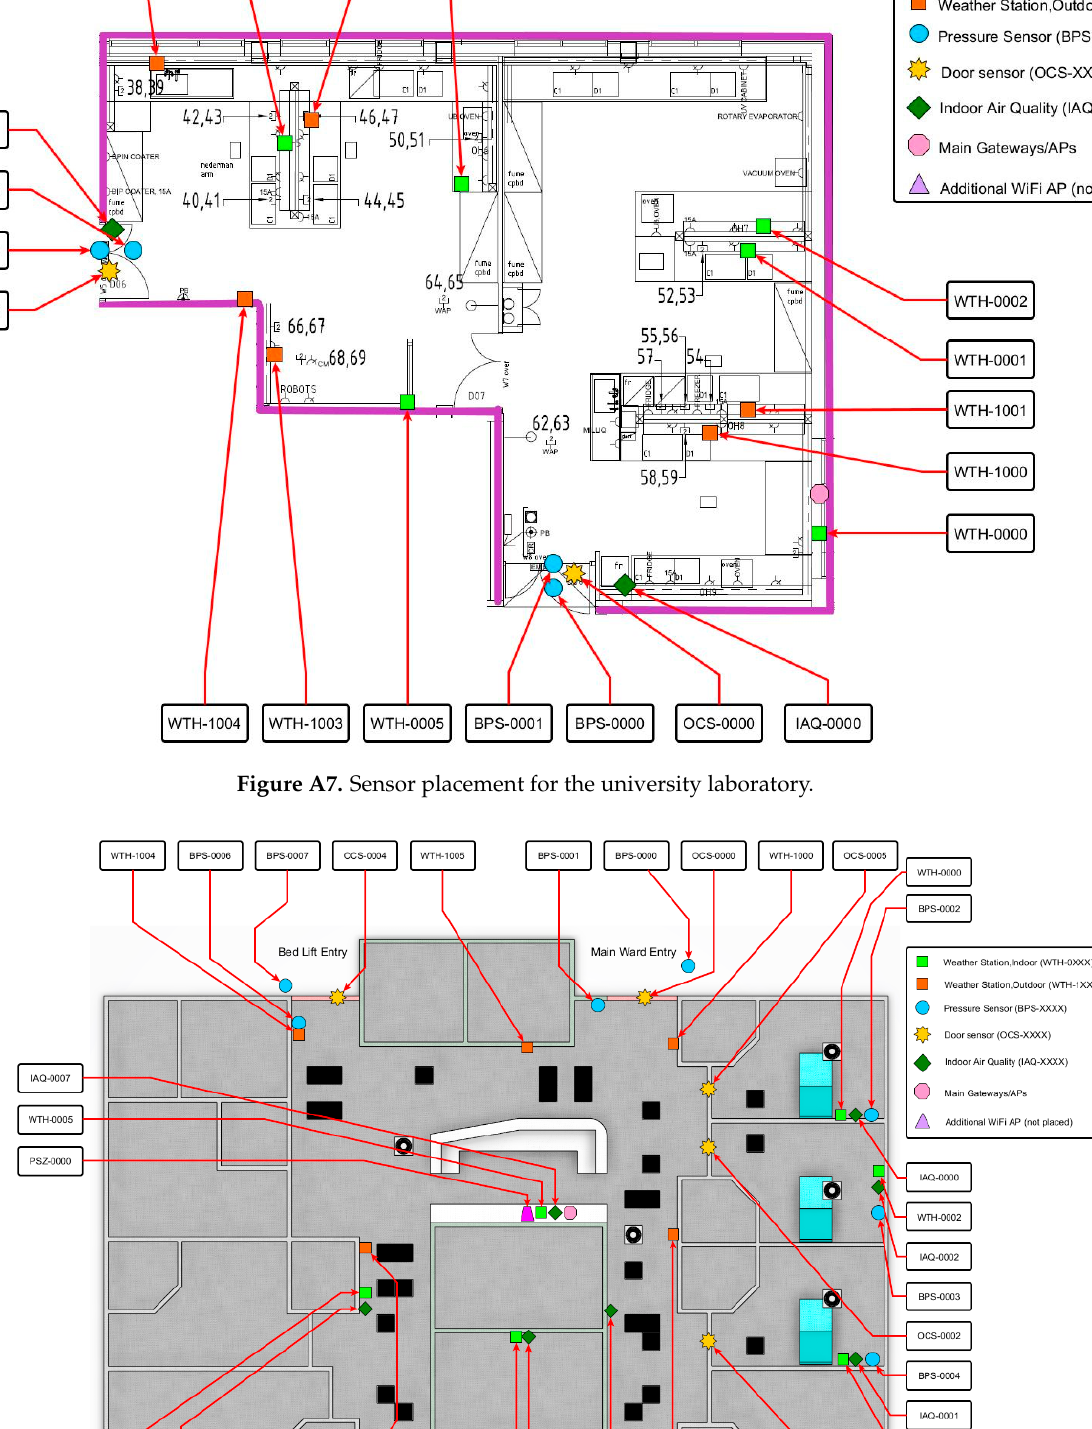
Figure A9. Sensor placement for the factory room. References 1.